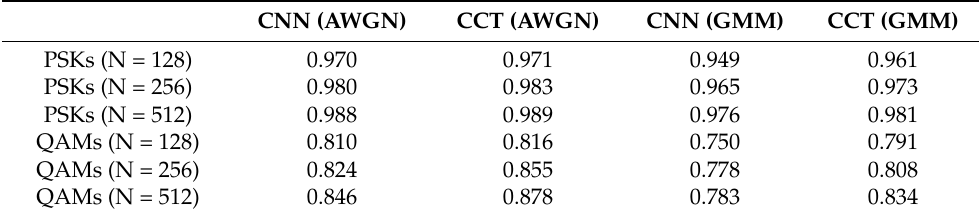
Table 7. Performance comparison of CNN and CCT of different modulation schemes under AWGN and non-Gaussian channel at N = 128, 256, and 512.